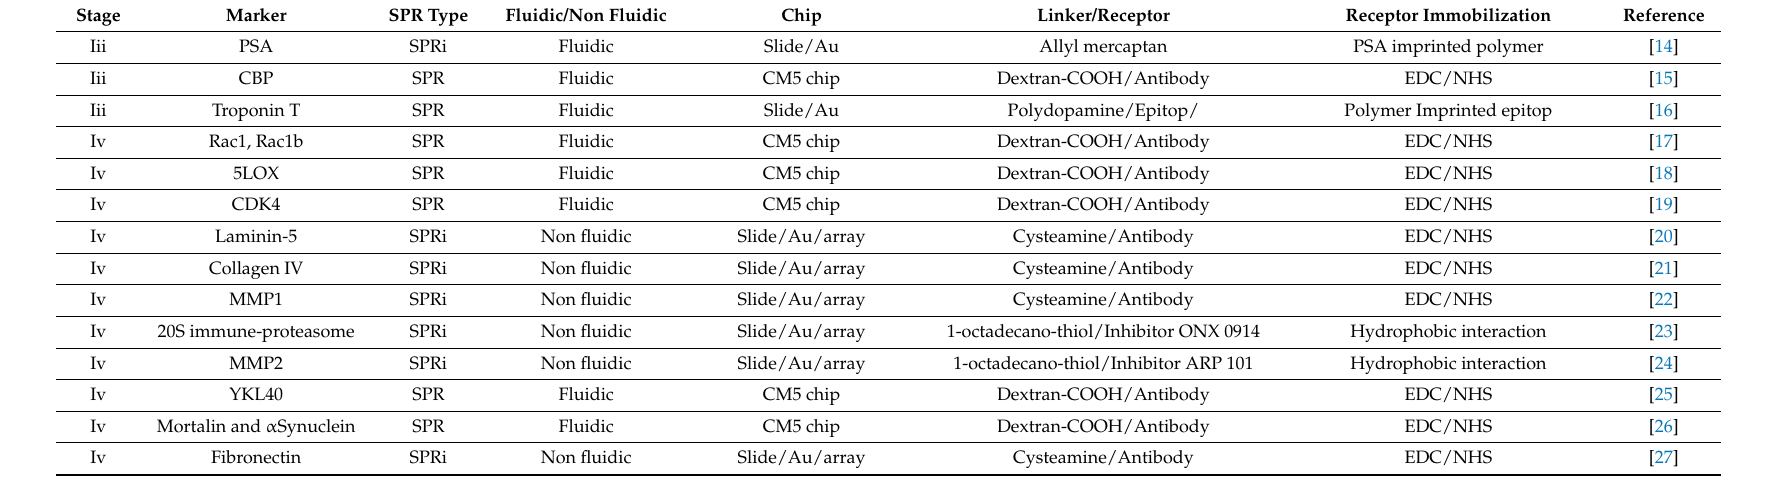
Table 2. Technical solutions for biosensors representing completely developed procedures.